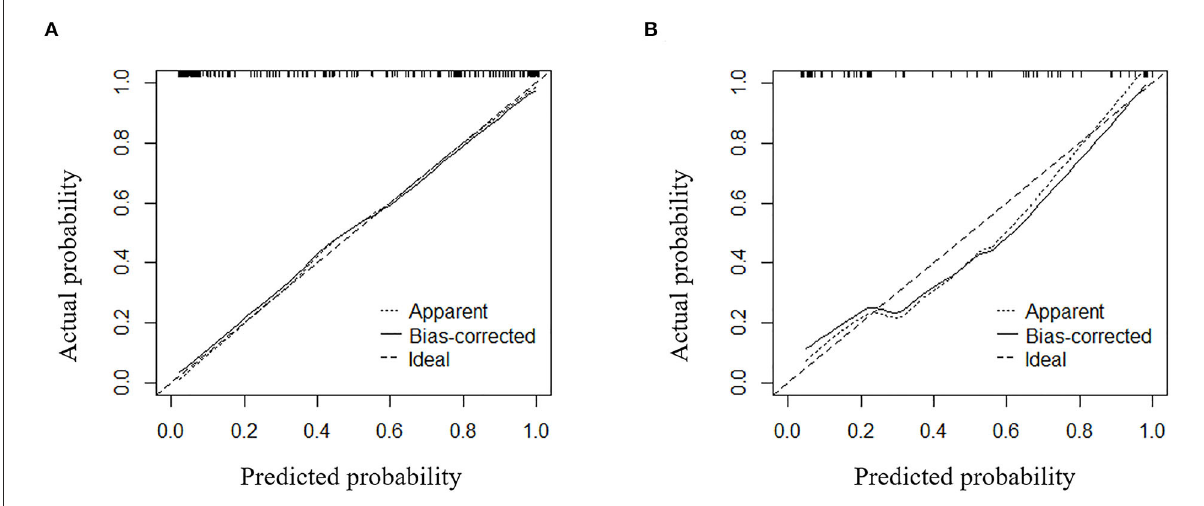
FIGURE6 Calibration curves for the combined model used for predicting > 5 CMBs for (A) the training cohort and (B) the validation cohort.